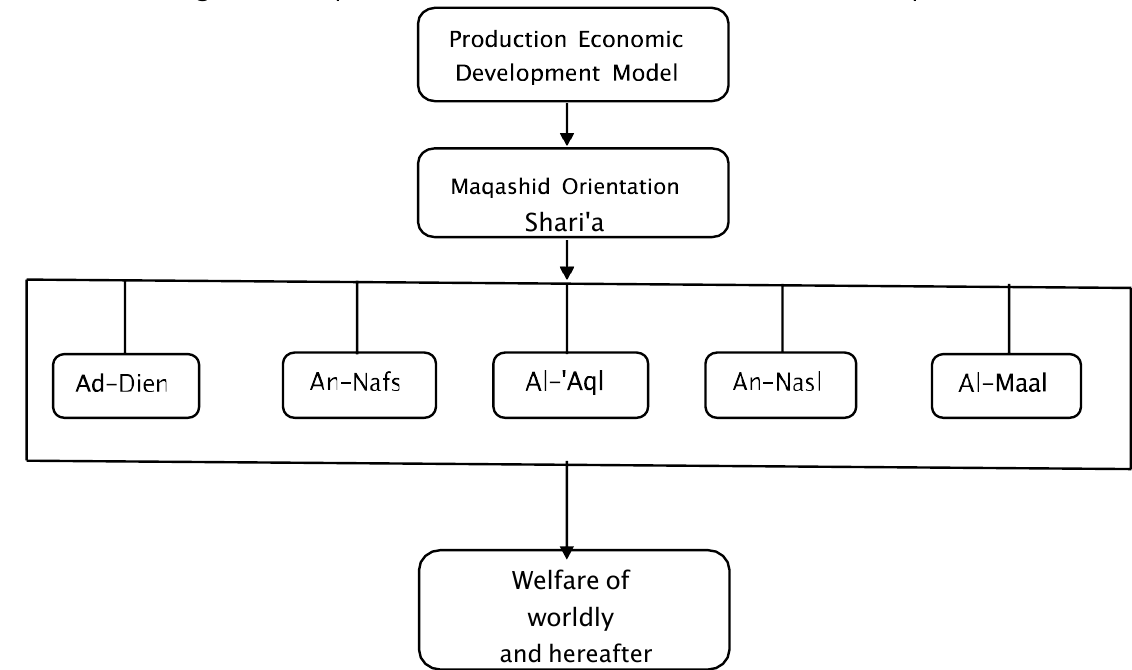
Figure 3. Maqashid al Sharia as a Model of Economic